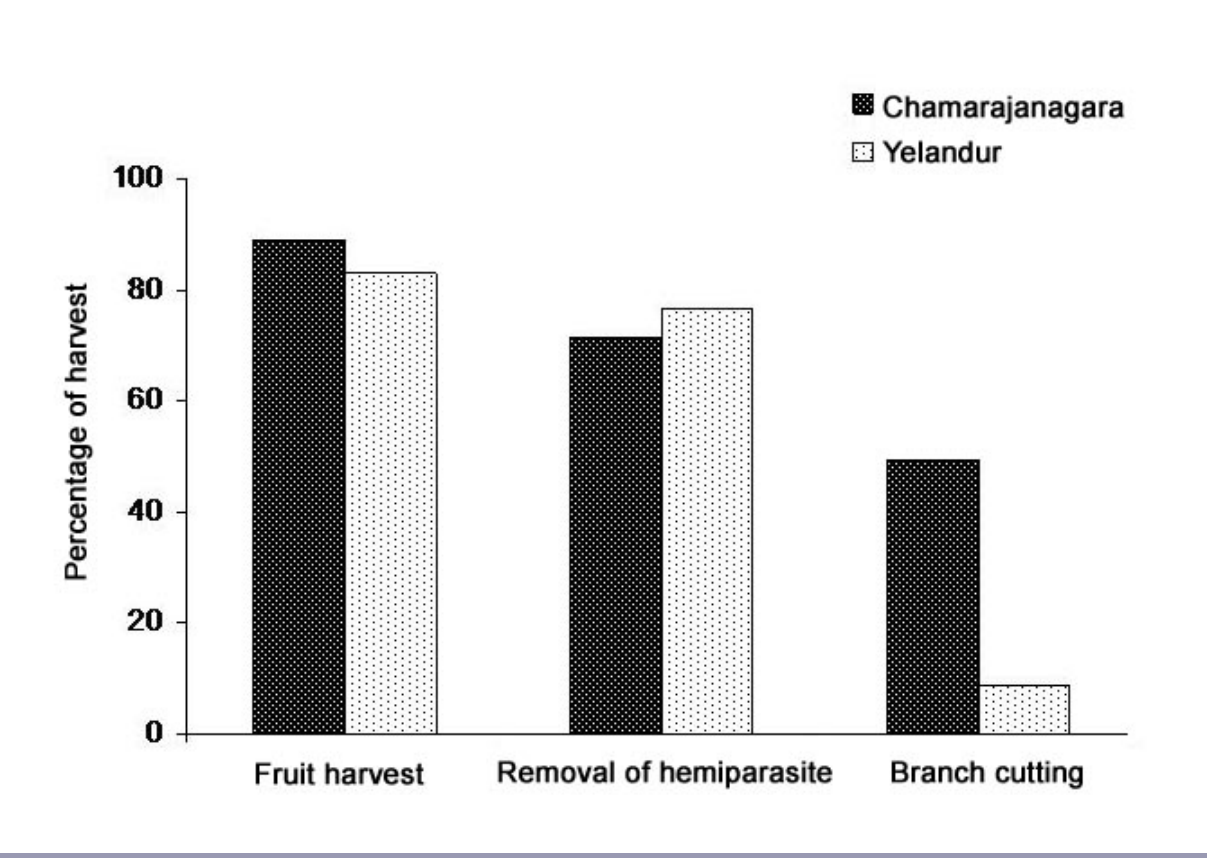
Fig. 5 . Differences in rates and types of harvest for amla ( Phyllanthus emblica and P. indofishceri ) in the Yelandur range, which has high rates of participatory resource monitoring (PRM) vs. the Chamarajanagara range, where PRM rates are lower, of the Biligiri Rangaswamy Temple Wildlife Sanctuary in